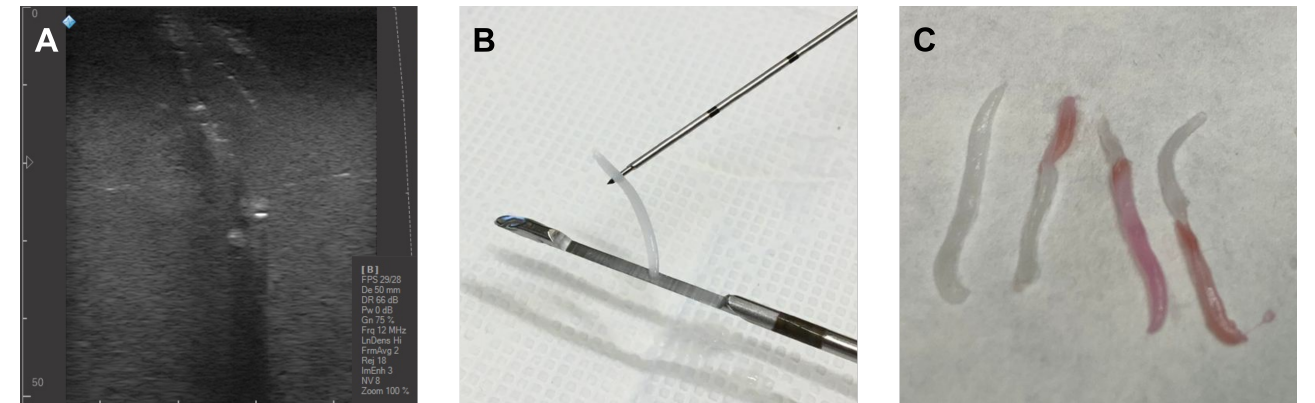
Figure 7. Coarse needle biopsy (CNB): ( A ) 18G needle tracks produced on the phantom after performing several CNBs on a solid inclusion. ( B ) Material extracted from the phantom when the CNB fails. The extraction of white material indicates that the biopsy was performed at an unsuitable depth, before reaching the inclusion or completely puncturing it. ( C ) Material extracted in subsequent CNBs. The level of success can be quantified by the proportion of light red material extracted, since this indicates the distance travelled within the phantom and the inclusion, before performing the